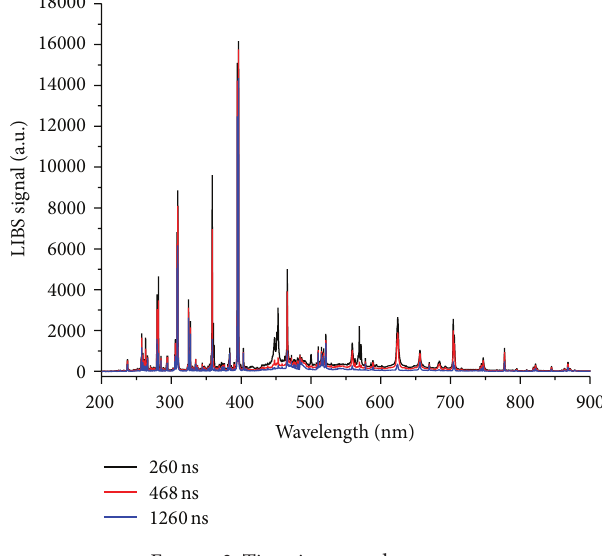
Figure 3: Time-integrated